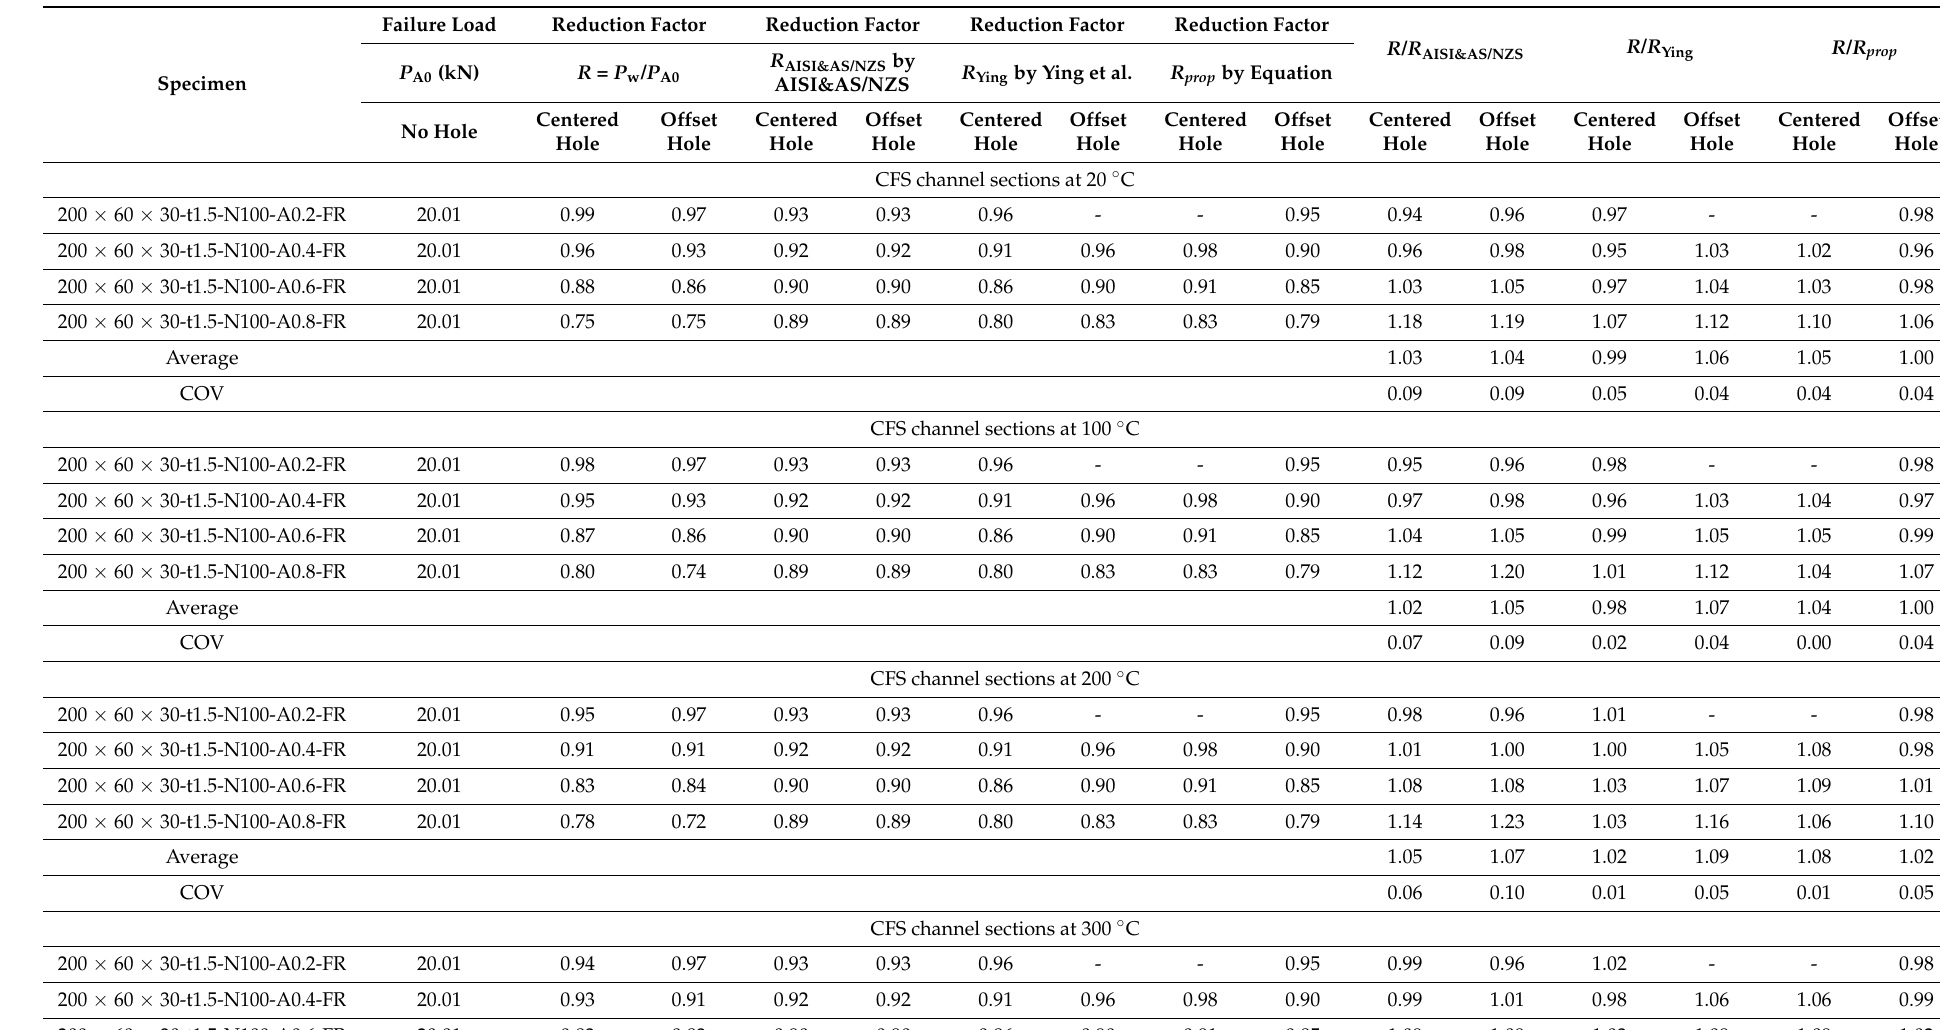
Table 6. Comparison of proposed equations with other methods for sections with unfastened